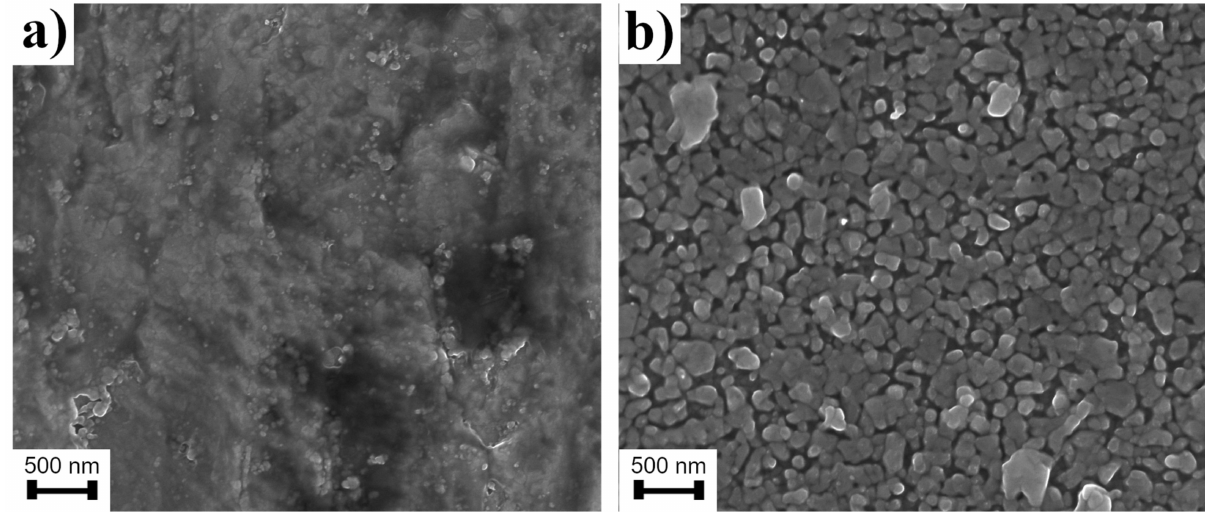
Figure 6. Surface of WO 3 nanopores after annealing at: ( a ) 500 ◦ C; ( b ) 550 ◦ C.